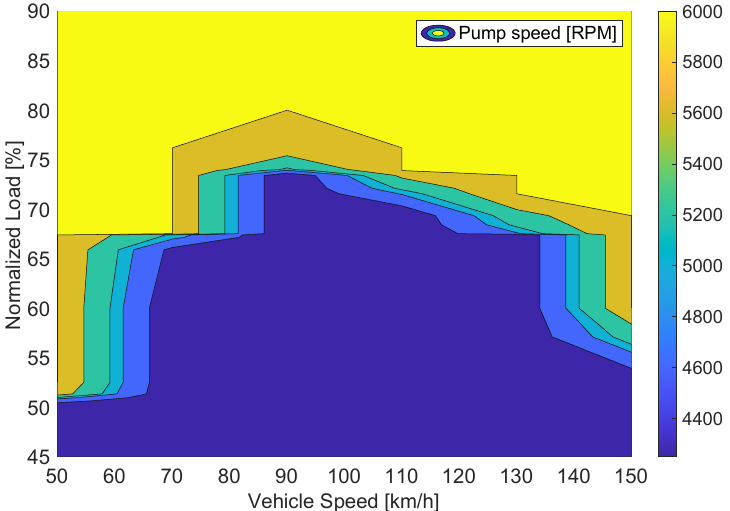
Figure 12. Optimized control strategy: optimized pump speed as a function of vehicle speed and propulsion normalized load.